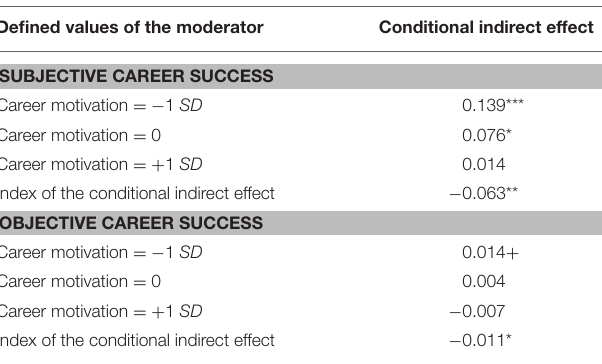
TABLE 4 | Conditional indirect effects of transformational leadership on career success ( N = 320). Defined values of the